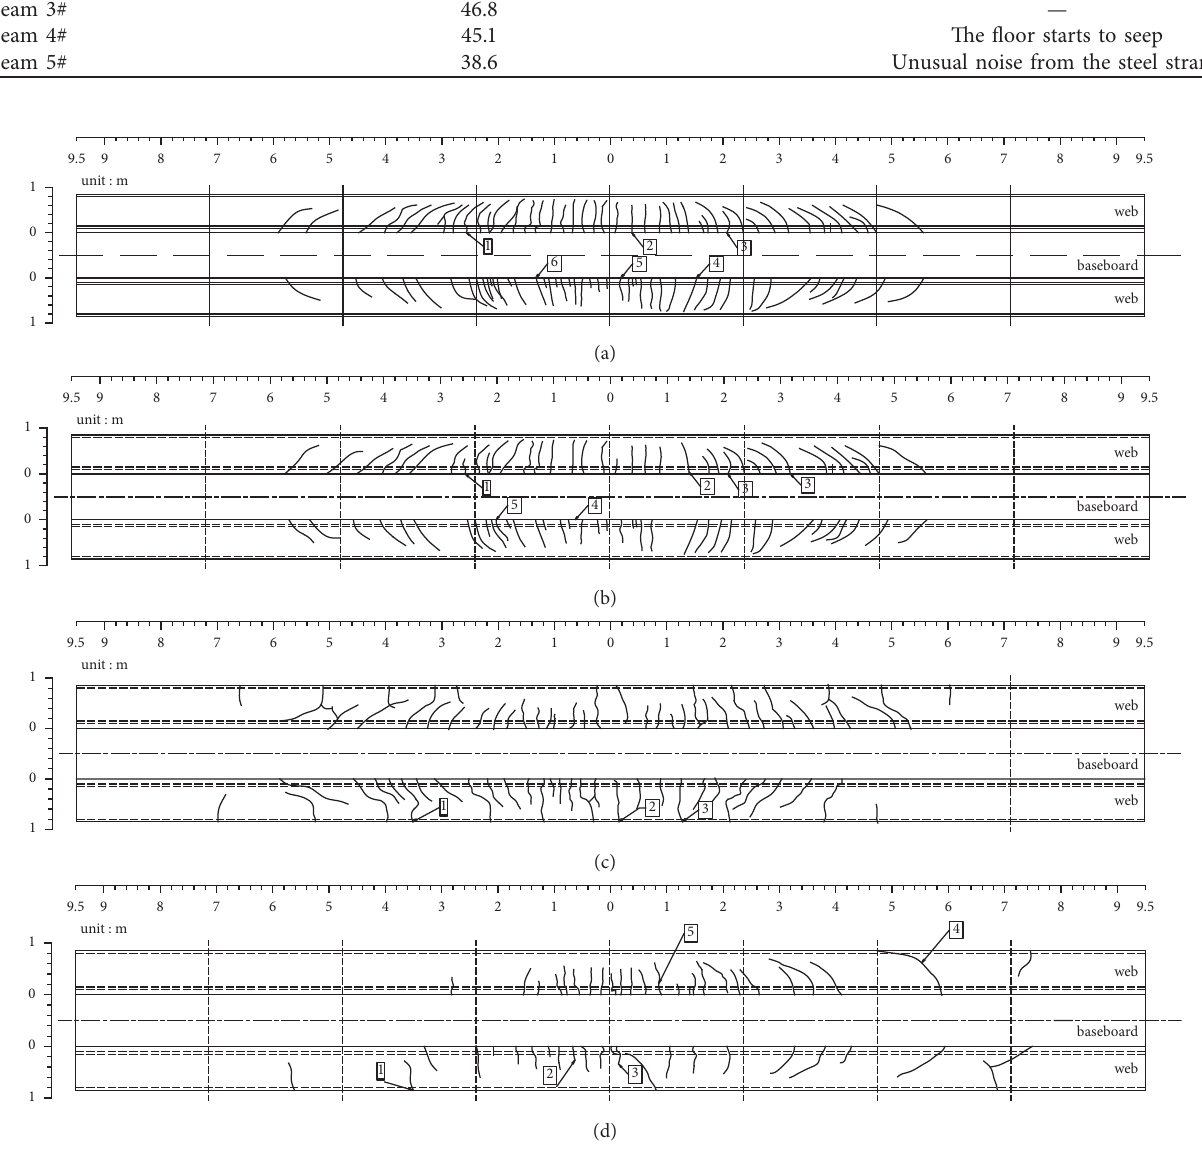
Figure 15: Schematic diagram of cracks at the end of limit loading. (a) Beam 2#. (b) Beam 3#. (c) Beam 4#. (d) Beam